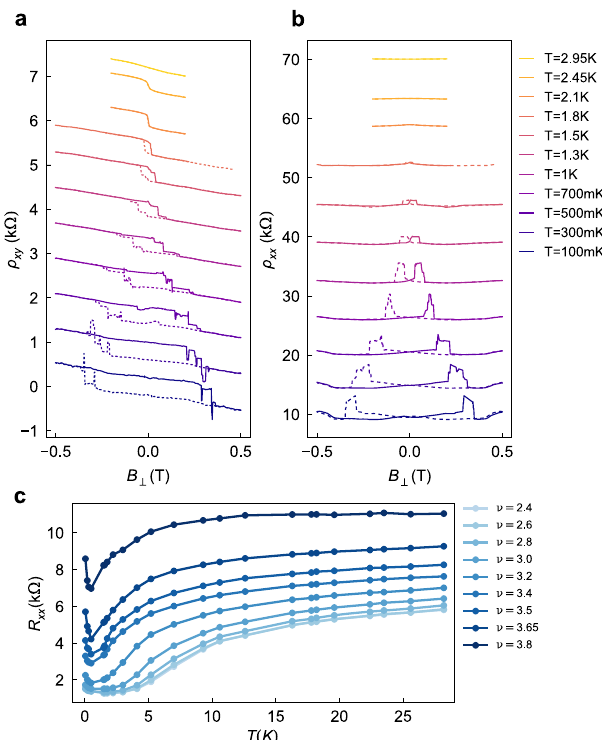
Fig. 4 | Temperature dependence of AHE. a Temperature dependence of hys- teresis loop ρ xy ( B ⊥ ) (D2, ν =3.57, D = − 0.43V/nm). Curves are offset by 800 Ω for clarity. b Temperature dependence of ρ xx ( B ⊥ ); curves offset by 6 k Ω for clarity. c Temperature dependence R xx ( T ) at B =0 in the halo region for ν in the range ν =2.4 – 3.8 (D1, D = −